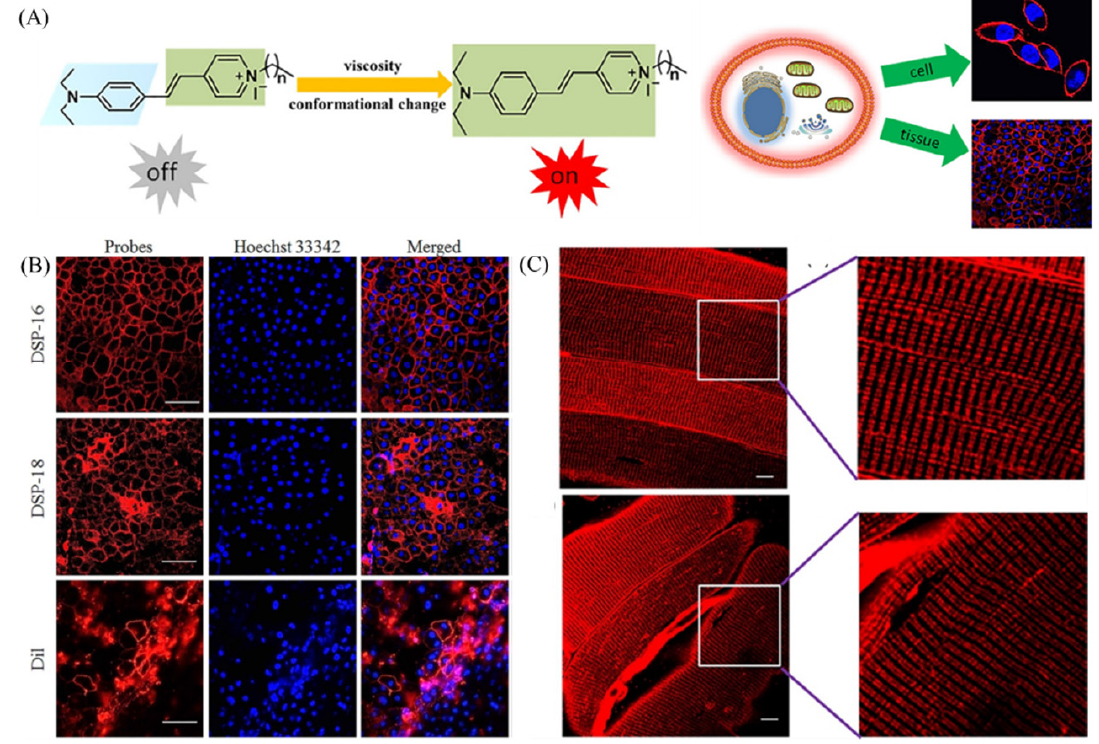
Figure 11. ( A ) Mechanisms of probes sensitive to plasma membrane viscosity and their applications. ( B ) Co-staining of viscosity-sensitive probes (DSP-16 and DSP-18), Dil (a commercial plasma membrane probe) with Hoechst 33342 (a commercial nuclei probe) respectively in hepatic tissues. ( C ) Confocal pictures of skeletal muscle tissues stained with DSP-16 and DSP-18. Reproduced from [59] with permission of the Elsevier, copyright 2021.